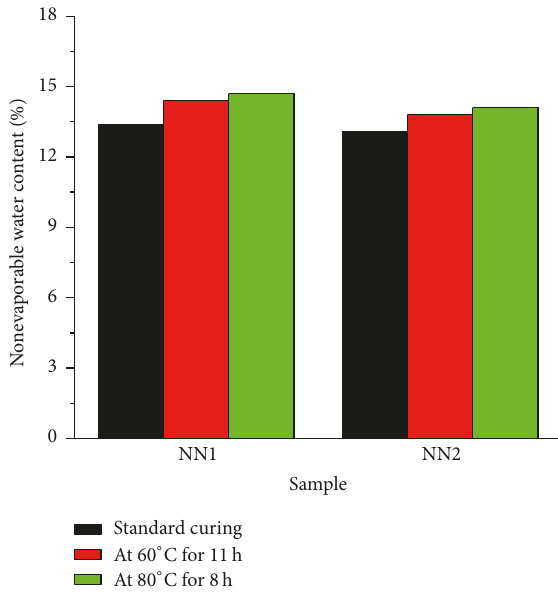
Figure 9: Nonevaporable water contents of the pastes containing phosphorus slag with W/B of 0.32 at the age of demoulding time.